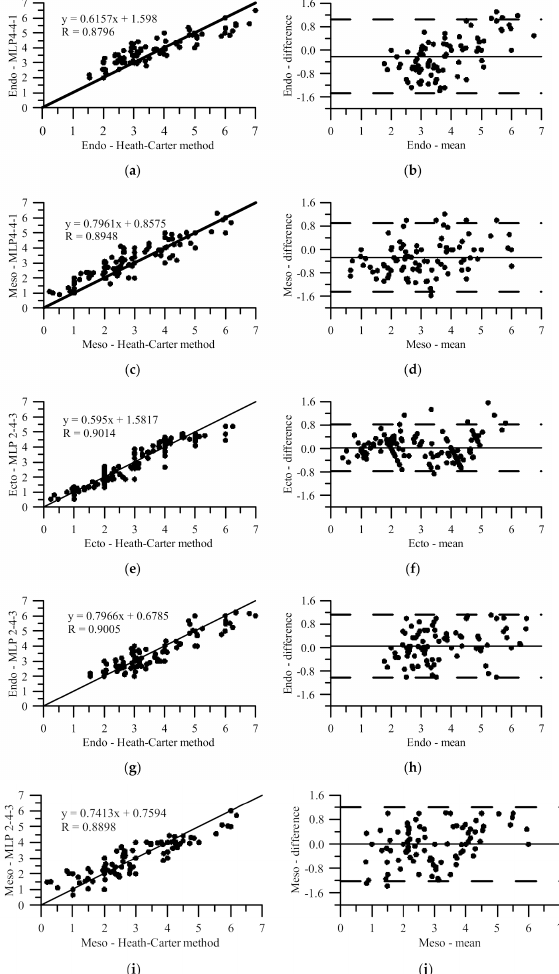
Figure A1. Scatterplot of ( a ) Ecto (MLP 4-4-1), ( c ) Meso (MLP 4-4-1), ( e ) Ecto (MLP 2-4-3), ( g ) Endo (MLP 2-4-3) and ( i ) Meso (MLP 2-4-3) somatotypes and levels of agreement graph from Bland-Altman analysis for ( b ) Ecto (MLP 4-4-1), ( d ) Meso (MLP 4-4-1), ( f ) Ecto (MLP 2-4-3), ( h ) Endo (MLP 2-4-3) and ( j ) Meso (MLP 2-4-3) somatotypes calculated using Heath-Carter